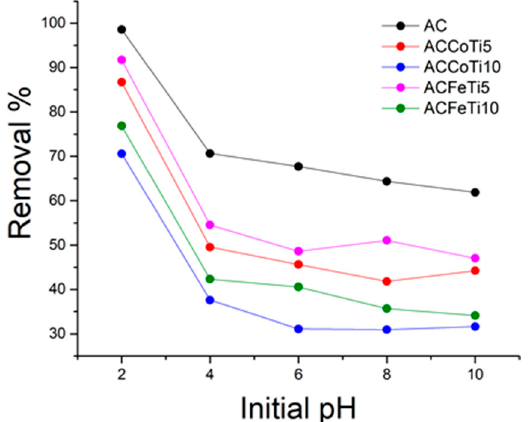
Figure 2. The effect of pH variation on the adsorption of CYF-4G on AC, ACFeTi5 and ACFeTi10, ACCoTi5 and ACCoTi10 (conditions: 1.2 g/L of adsorbent dosage; concentration of (CYF-4G) = 100 mg/L, 120 rpm, 4 h agitation time, and temperature 25 °C).